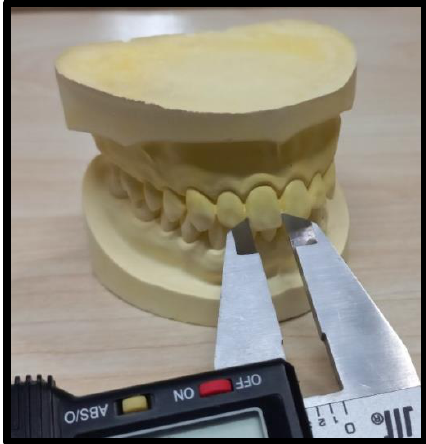
Figure 2. The dental stone cast mesiodistal teeth width measurements with a Vernier caliper.